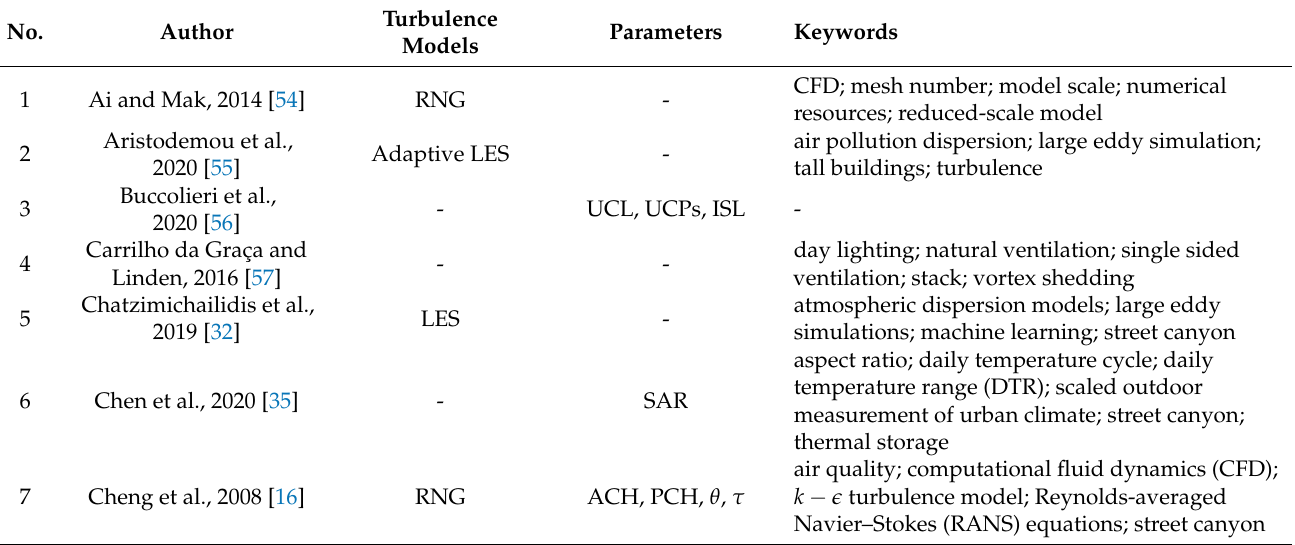
Table 4. Overview of studies of fictitious urban areas without validation comparison with experi- mental or numerical data: adopted turbulence models and parameters, and listed